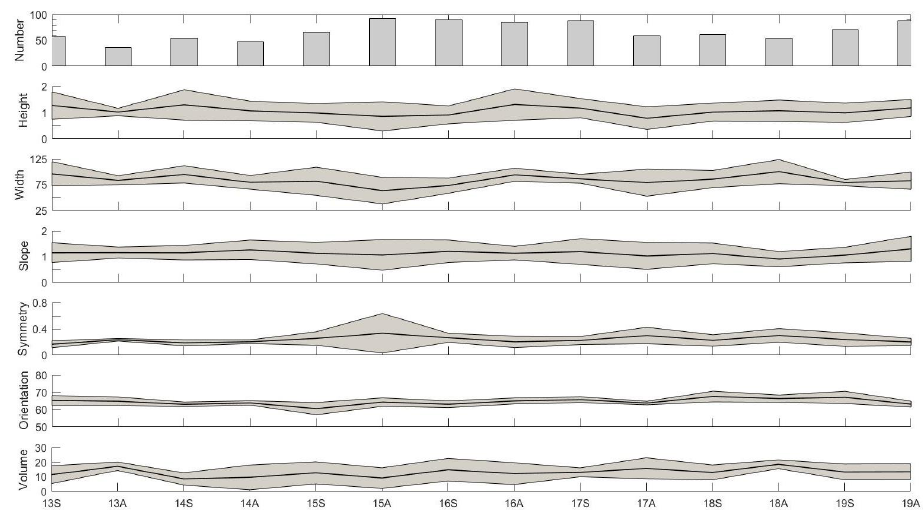
Figure 6. Variability in bar morphometry: bar number detected over the study site, crest height (m), width (m), seaward slope (°), symmetry (dimensionless), orientation (° relative to North), volume (m 3 /m). Solid lines represent the average and grey envelopes indicate the +/− one standard deviation.